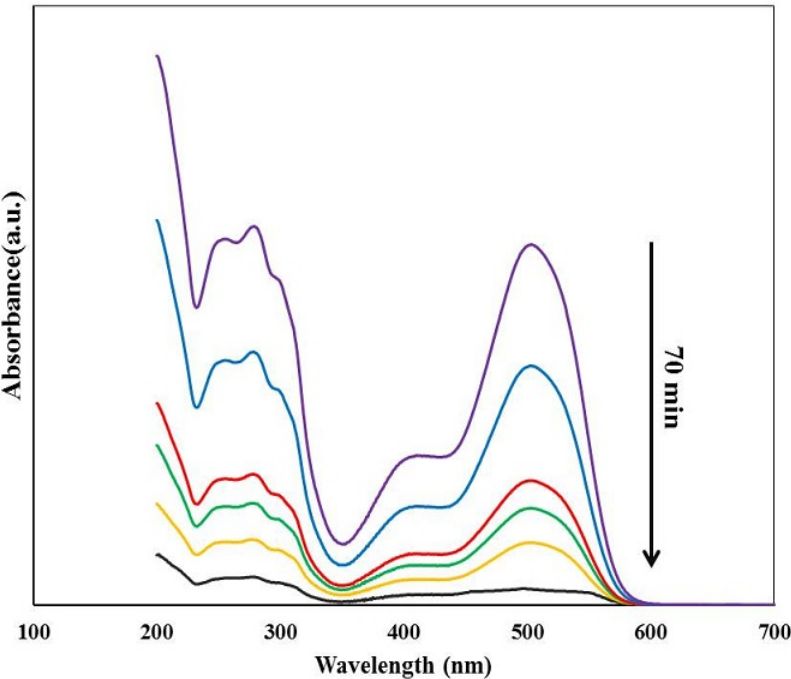
Figure 13. The decolorization of RB19 with different Eu 3+ content, [Dye] = 20 mg/L, [Catalyst] = 1.25 g/L, pH = 6.